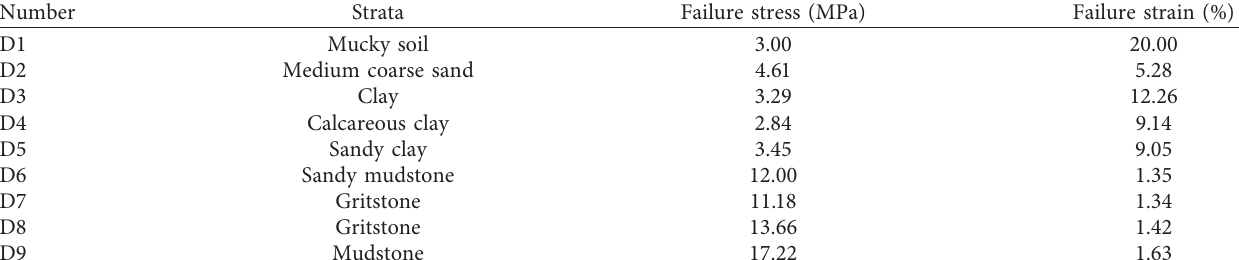
Table 6: Parameter comparison of failure stress and failure strain of different rock and soil strata at − 10 ° C.